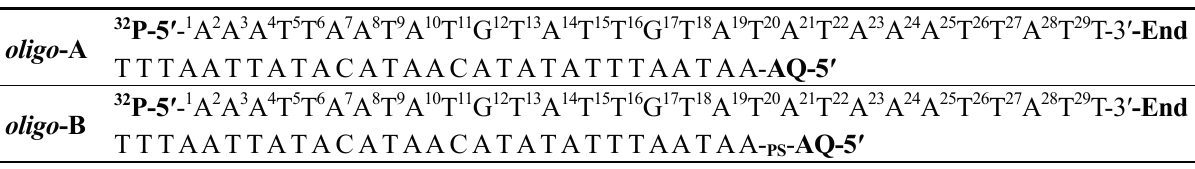
Table 1. Structure/nucleobase sequence of ds -oligonucleotides with phosphorotioate linkage